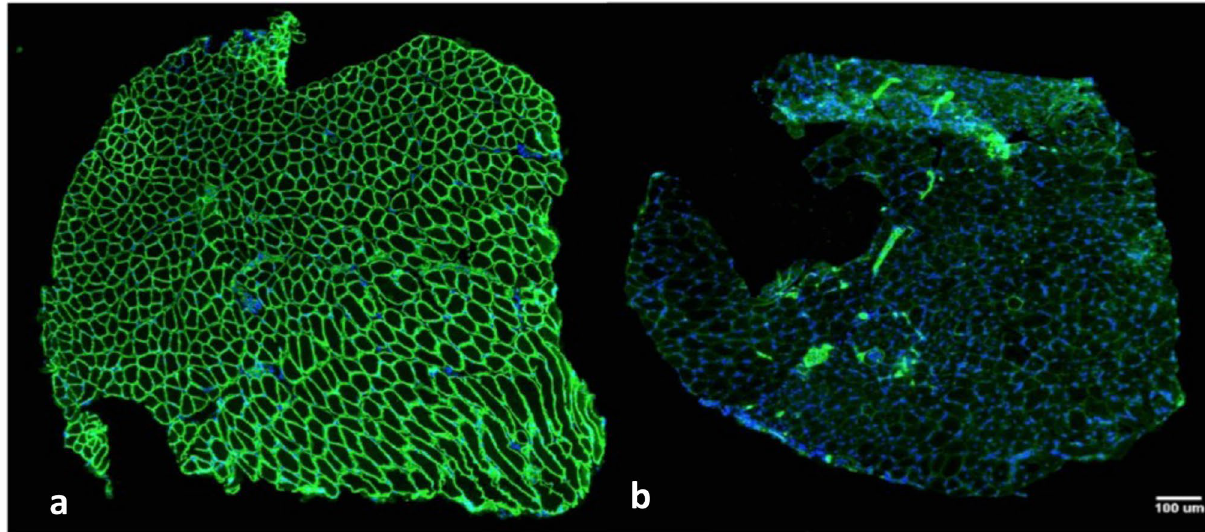
Figure 1. Photomicrographs of soleus muscle immunolabelled by dystrophin antibody. A wt SED sample, with dystrophin protein shown in green and nucleus is shown in blue (DAPI). B mdx SED sample, with nucleus shown in blue, without the presence of dystrophin protein. Bars: 100 μm. Abbreviations: wild-type Sedentary group ( wt SED); mdx Sedentary group ( mdx